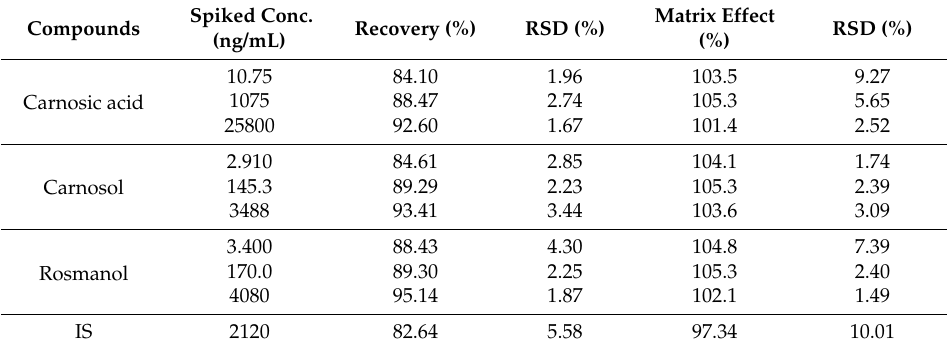
Table 5. The absolute recovery and matrix effect of three diterpenes and I.S. in rat plasma ( n = 6). Spiked Conc. Recovery RSD Matrix Effect RSD Compounds (ng/mL) (%) (%) (%) (%) Carnosic acid